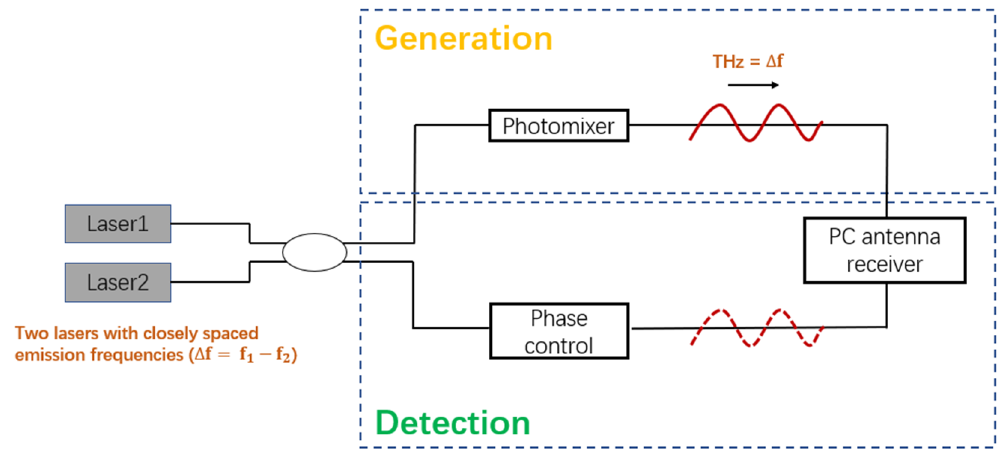
Figure 2. Schematic of a typical setup of photonics-based CW THz system.